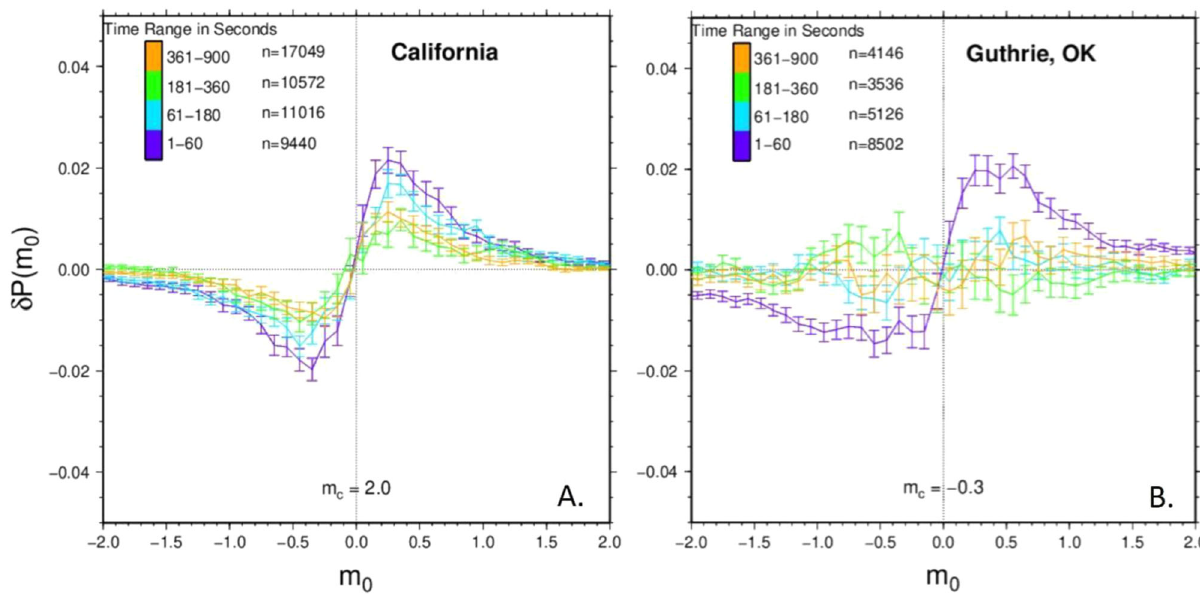
Fig. 4 | Comparison of A) California and B) Guthrie cumulative distribution aftersplittingthe fi lteredversionsofthesecatalogsintodifferenttimeranges. n = number of events, m c = magnitude of completeness. The fi ltered Guthrie